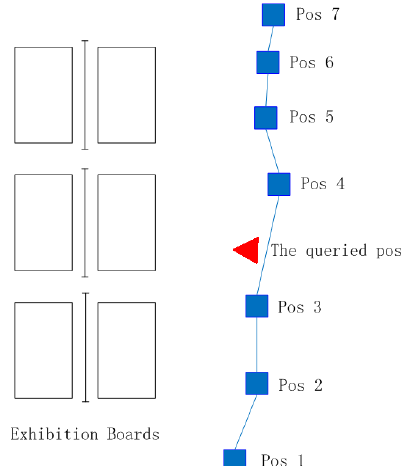
Fig. 9 The calculated camera position from the newly captured image SIFT and SURF we deployed is based on OpenCV [13], while ASIFT is provide by the author 1 . The original version cost around 20 seconds to matching an image pair. There remains space to lessen the computing time.